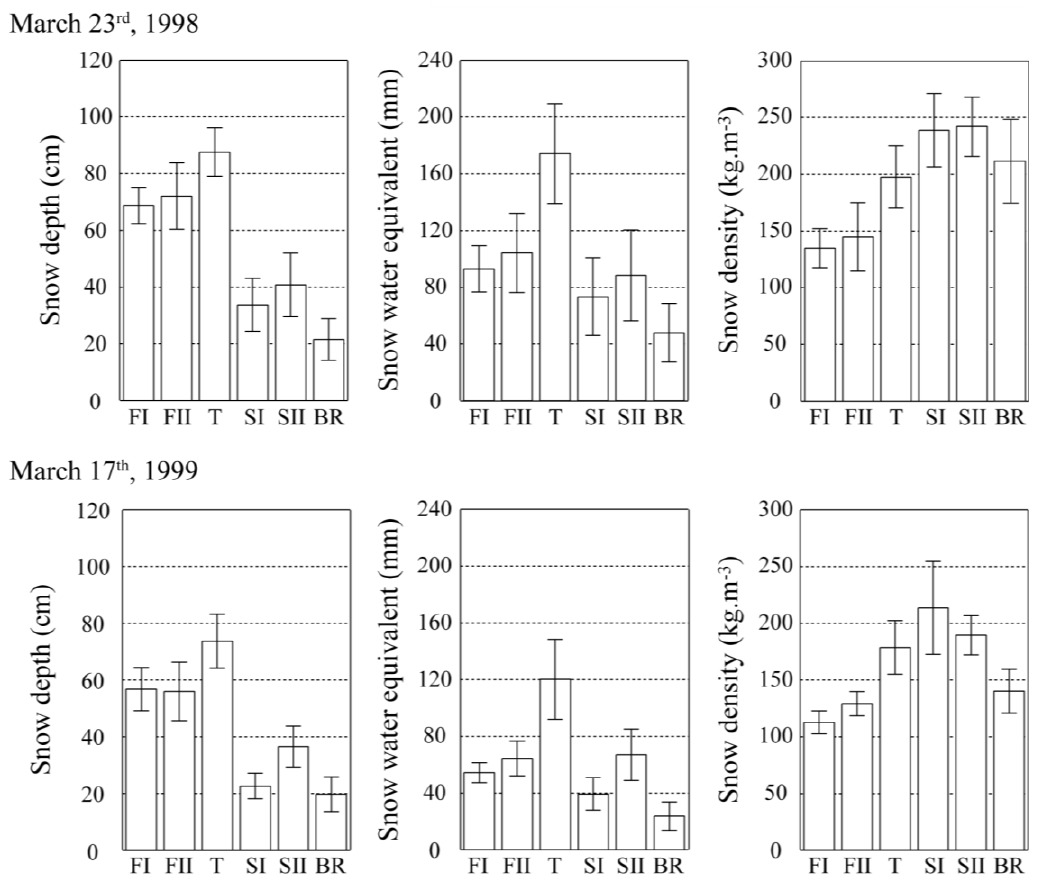
Figure 3. The in situ snow measurements ( i.e. , depth, water equivalent and density) were acquired coincident with the RADARSAT-1 overpasses during the period of peak snow accumulation for the winters of 1997/98 and 1998/99. The mean values are shown ±1 standard